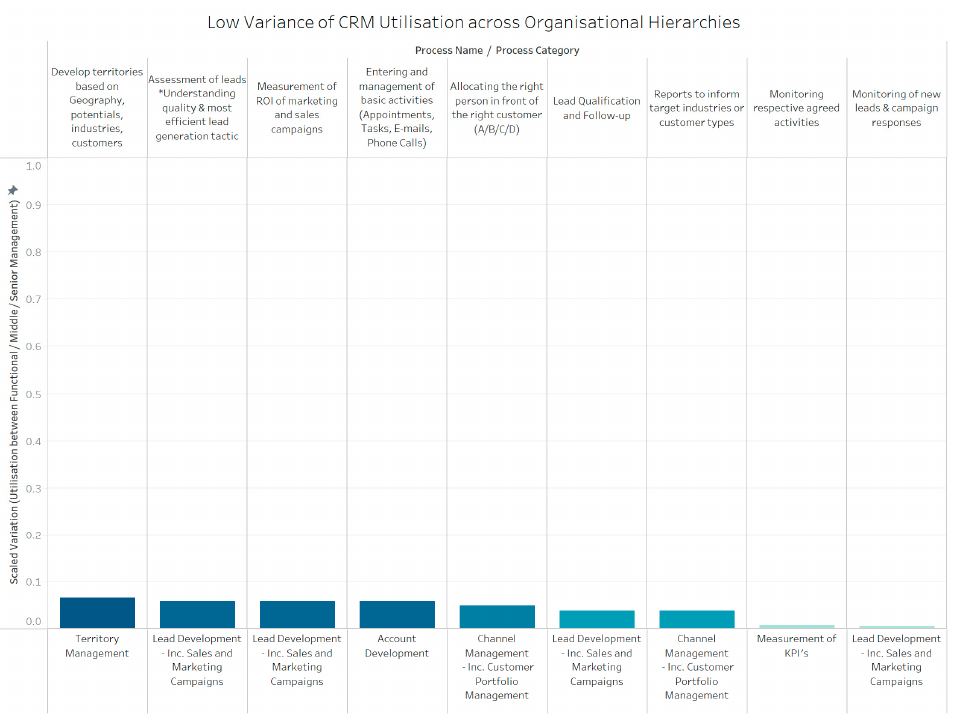
Figure 4. CRM Processes with a high variance of utilisation across organisational hierarchies, as developed for this study. Finally, Figure 5 below illustrates CRM processes with a high variance.